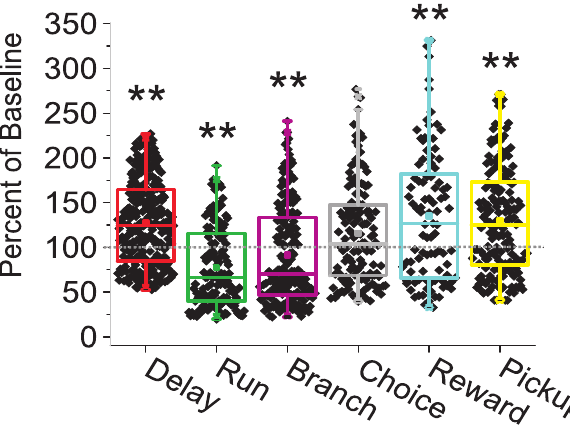
Figure 3. Effects of stress on task-related discharge rates of pl PFC neurons. Average discharge rates of WS-type pl PFC neurons during stress conditions were quantified for each behavioral interval of correct trials and plotted as a percent change from baseline conditions (1 st recording session) for matched behavioral intervals trials with identical T-maze arm choices. Box and whisker plots illustrate that during stress, discharge rates within the Delay, Reward, and Pickup behavioral intervals are increased. During the Run and Branch behavioral intervals, discharge rates are suppressed under stress conditions. Colored box and whiskers designate the first and fourth quartiles and median line (box), distribution mean (dot), and 5–95% range of the data (whiskers). (**p , 0.01 FDR corrected T-Test compared to baseline).